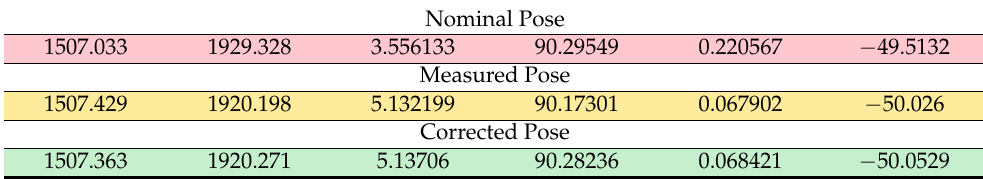
Table 2. Positions (in tracker reference frame) before and after calibration.